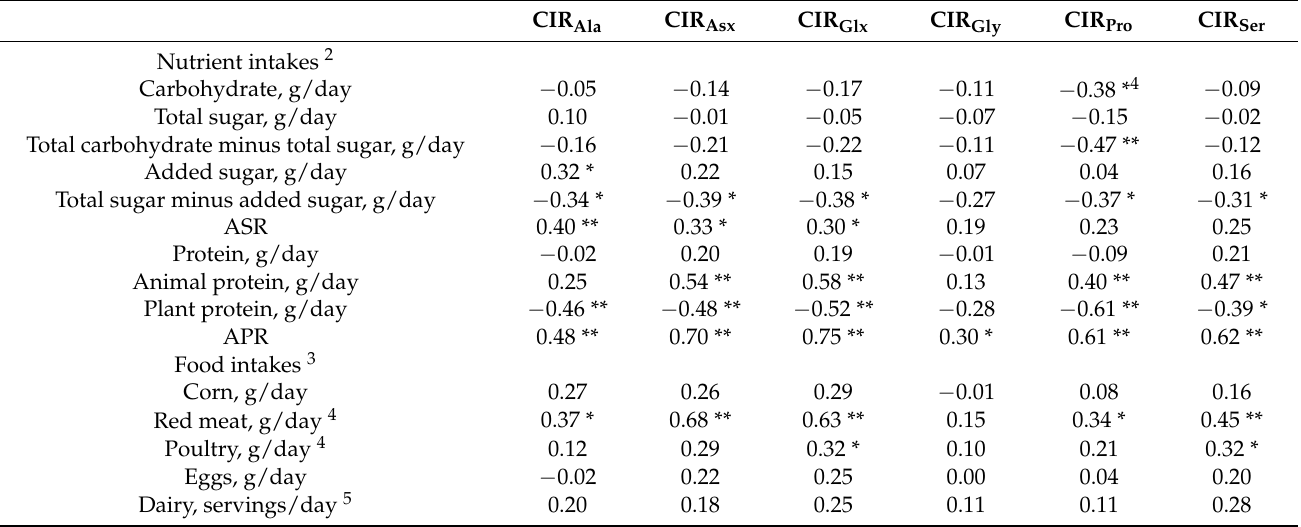
Table 2. Correlations of nonessential amino acid CIRs with 15-day mean dietary intakes ( n = 99) 1 . CIR Ala CIR Asx CIR Glx